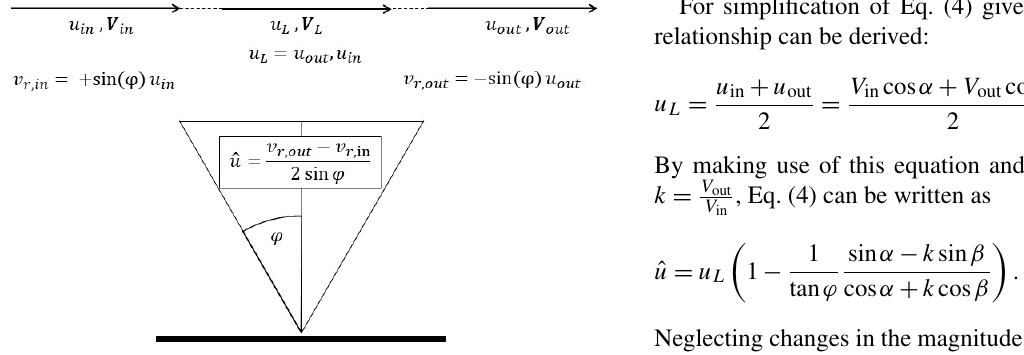
Figure 3. Generic flow case with a lidar placed in flat terrain in a homogeneous wind